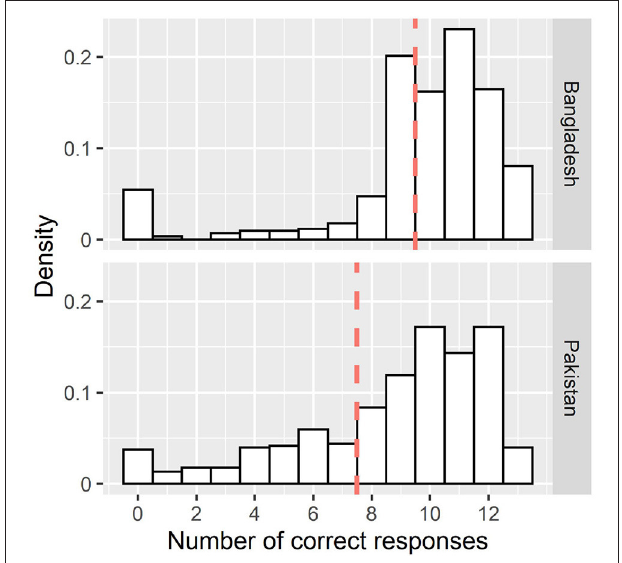
FIGURE 2 | Distribution of the number of correct responses to the 13 questions relating to symptoms of COVID-19. The dashed line represents the cut off to determine “poor” Knowledge (lower 25% of the